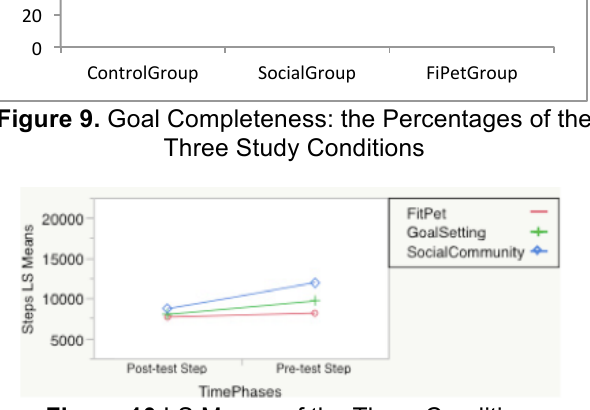
Figure.10 LS Means of the Three